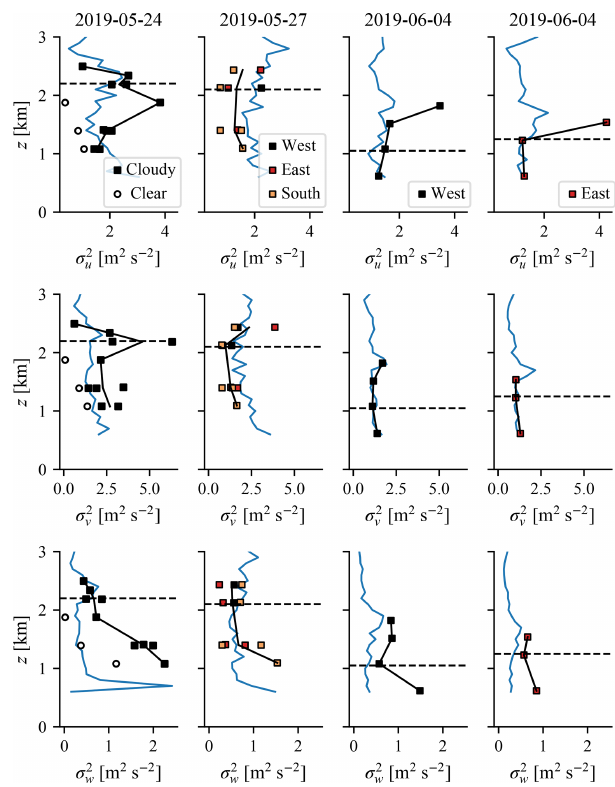
Figure 10. Variance of u (cid:48) , v (cid:48) , w (cid:48) for each flight.